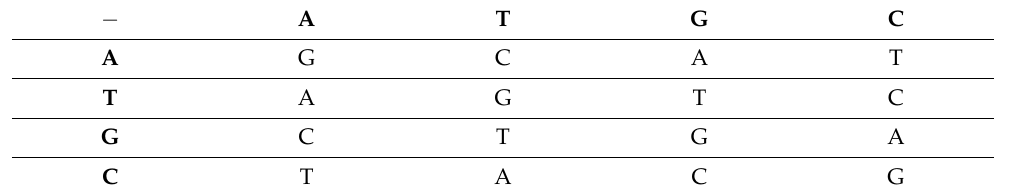
Table 3. Rule 3 for DNA subtraction.